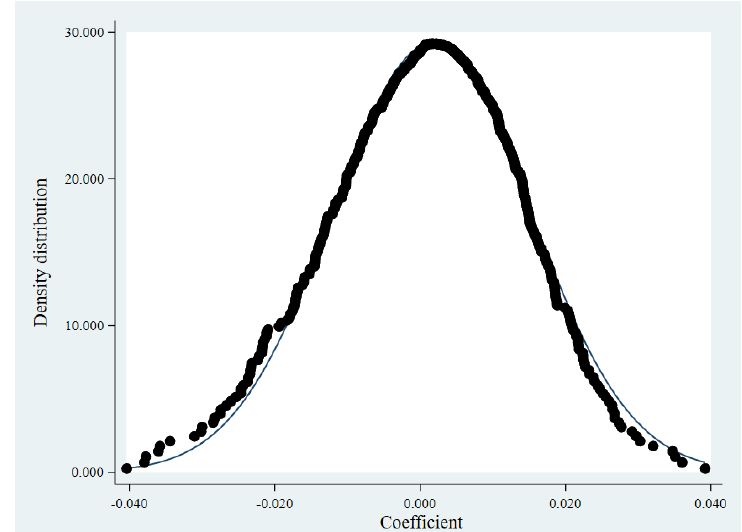
Figure 7. Placebo